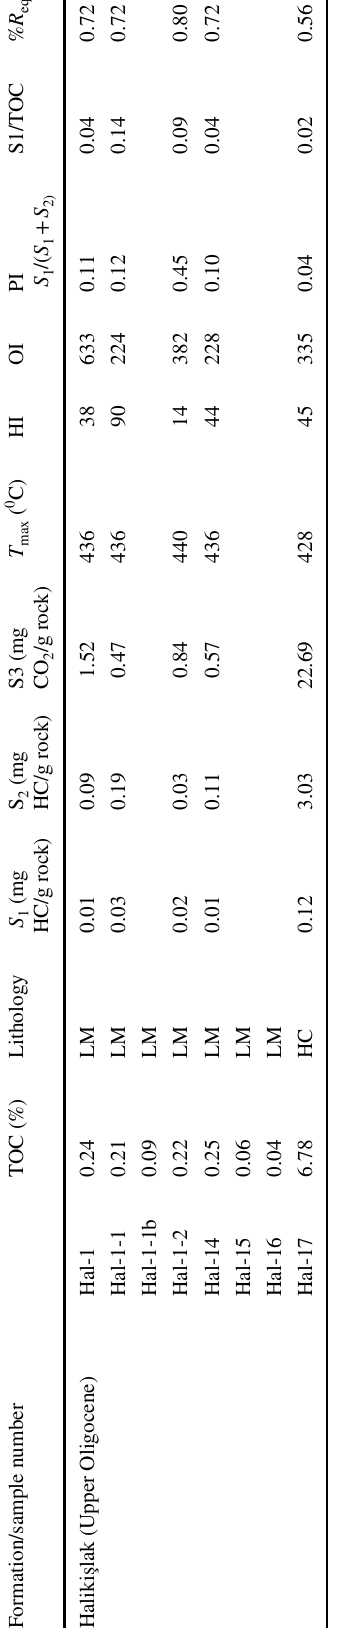
max for the ana-